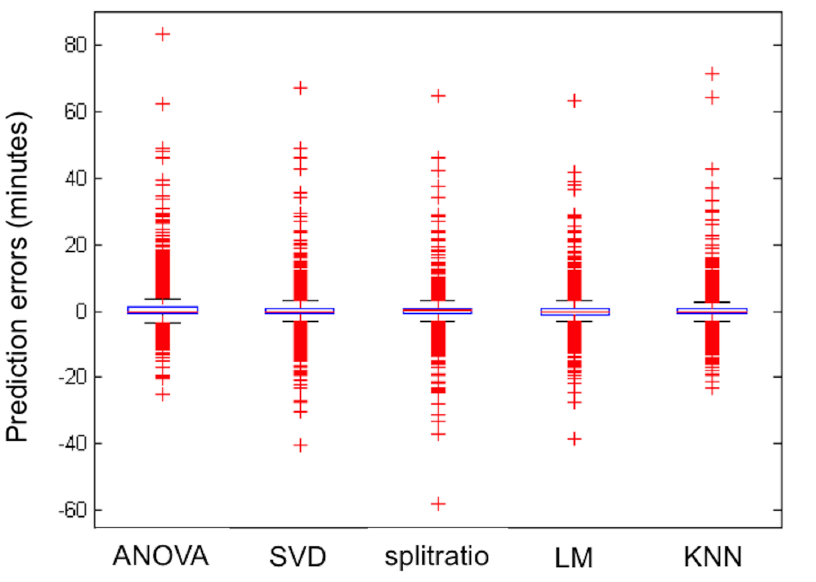
Figure 4. Prediction error box plots. Boxplots of prediction errors in the validation dataset: the ‘box’ in the middle includes 50% of runners. Red marks are individual very large errors.